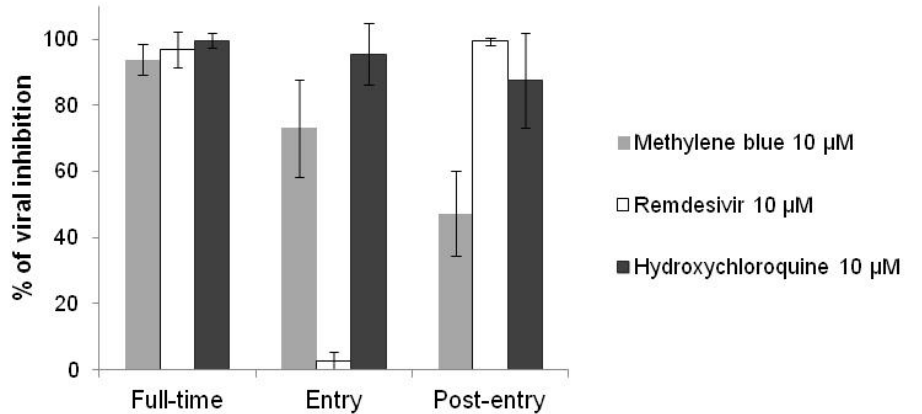
Figure 2. Antiviral activities of methylene blue, hydroxychloroquine and remdesivir at 10 µM against the SARS-CoV-2 IHUMI-3 strain in vitro. For “full-time” treatment, Vero E6 cells were infected with the IHUMI-3 strain for 48 h after pre-incubation of the cells with one of the three drugs for 4 h. For “entry” treatment, the cells were infected for 2 h after pre-incubation for 4 h and then the virus–drug mixture was replaced with fresh medium maintained for 46 h. For “post-entry” treatment, the cells were infected for 2 h and then incubated with drug for 46 h. Error bars represent standard deviation of 6 to 9 independent experiments.